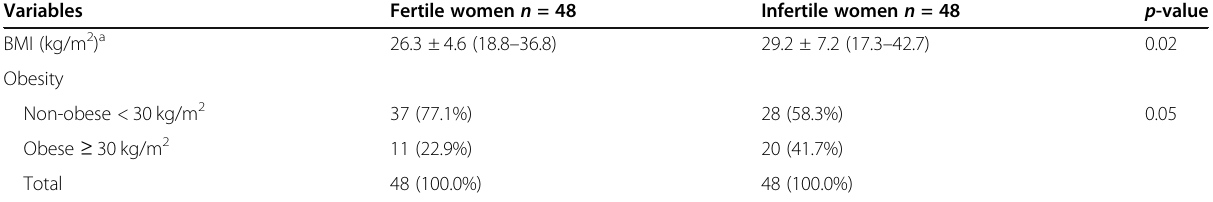
Table 3 Anthropometric and lifestyle findings of fertile and infertile women attending MNH, Dar es Salaam, Tanzania